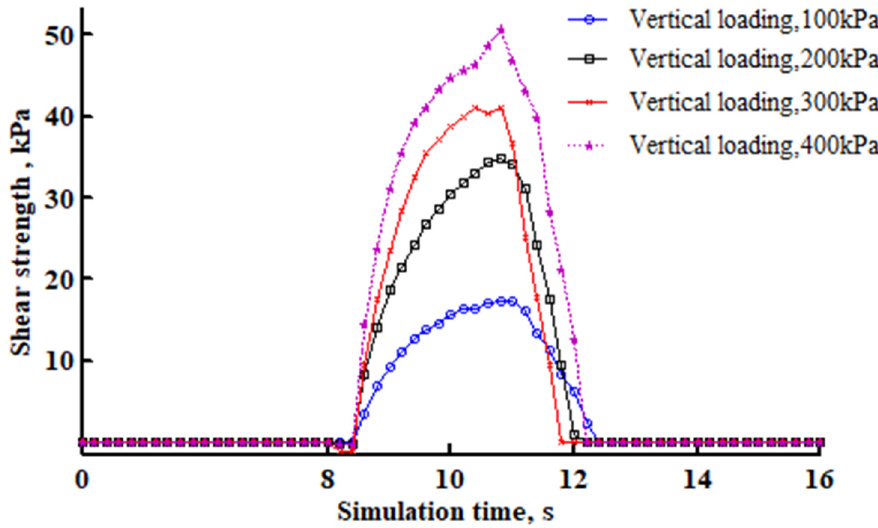
Figure 15. The relationship between the shear strength and the simulation time of the soil particles under different vertical loadings.